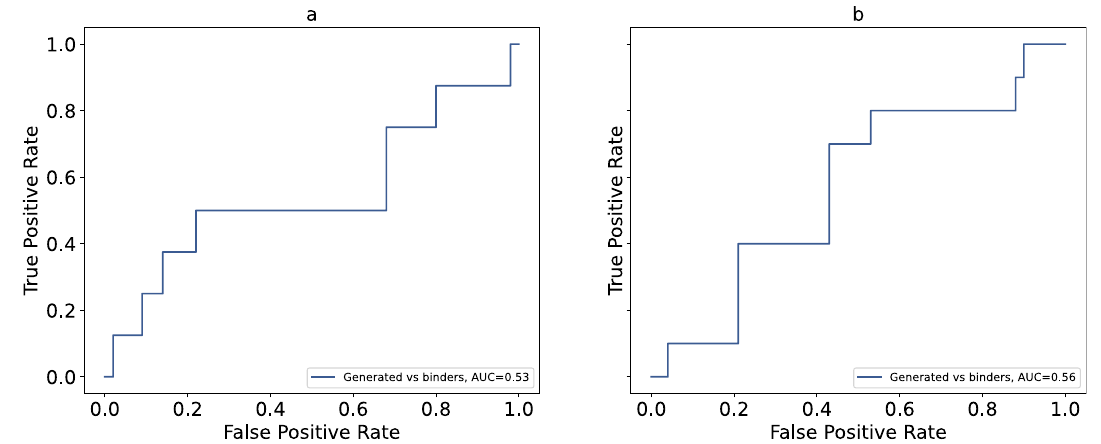
Figure 3. ROC comparison of known binders versus molecules generated for IGF-1R and VEGFR2 and corresponding AUC for the following structures: ( a ) structure of IGF-1R with PDB code 3O23, ( b ) structure of VEGFR2 with PDB code 3BE2.